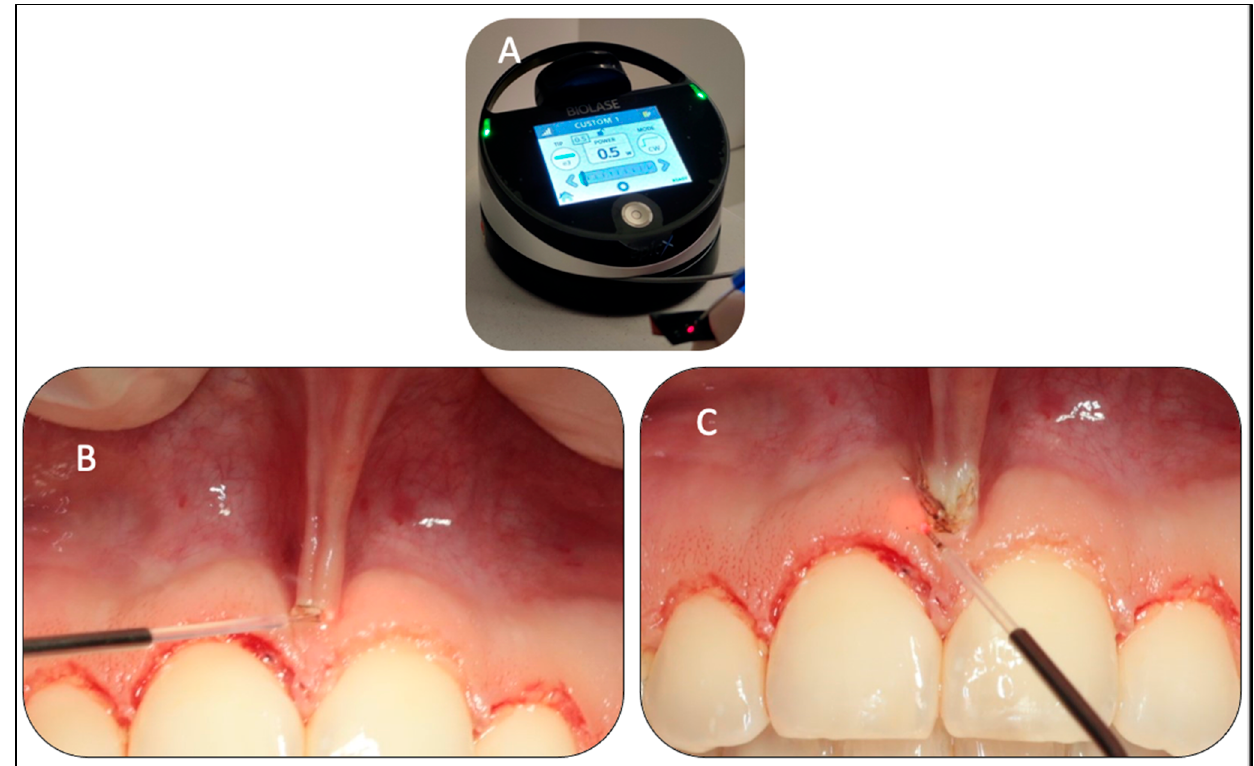
Figure 6. ( A–C ) . Clinical photo ( A ) shows the tip initiation of the λ 940 nm diode laser fibre using articulating paper, aiming to generate the maximum energy on its tip. Photo ( B ) is a peri-operative image, illustrating the upper midline frenum under stretch as well the light–tissue interaction, illustrating the initial ablation of the frenum attachments. Photo ( C ) is a peri-opearive image, showing the laser fiber direction at 90° to the frenum tissue and parallel to the alvoalr bone and away from the teeth positons.